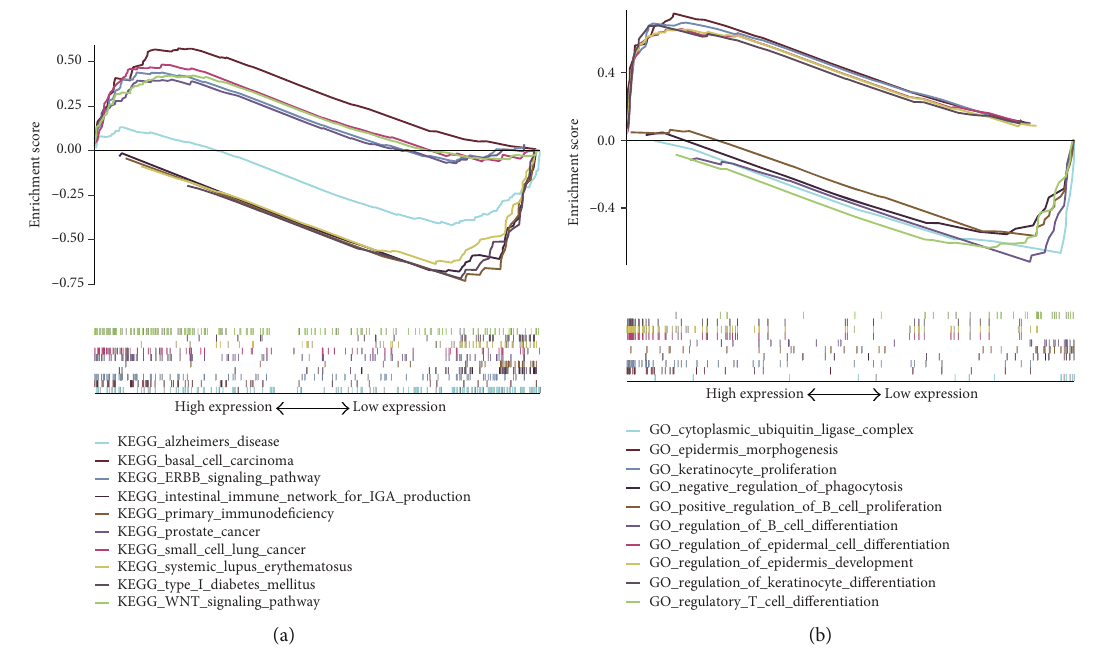
Figure 6: Gene function enrichment map. (a) GSEA results showed di ff erential enrichment of genes in KEGG with FLG expression. (b) GSEA results showed di ff erential enrichment of genes in GO with FLG